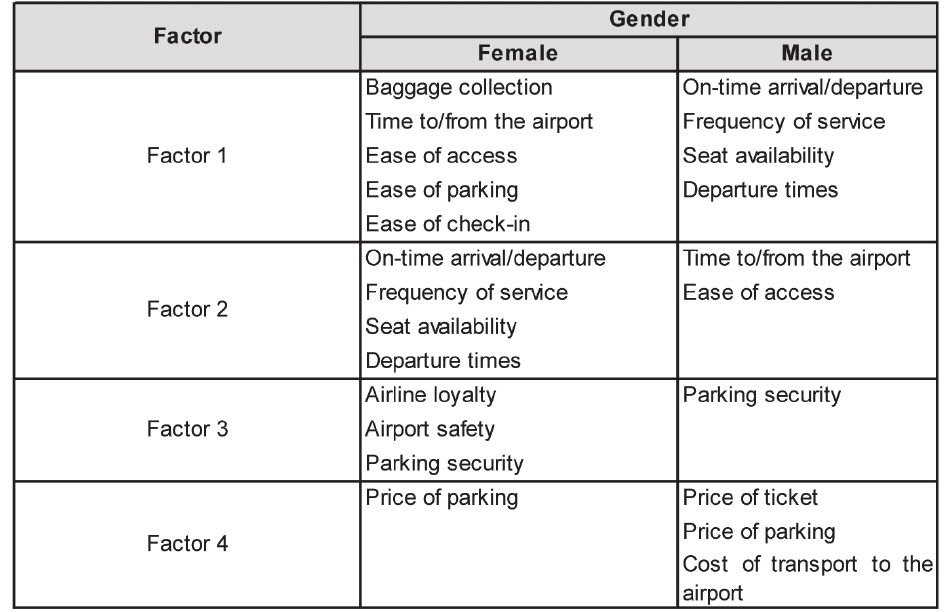
Table 11: Decision factors by